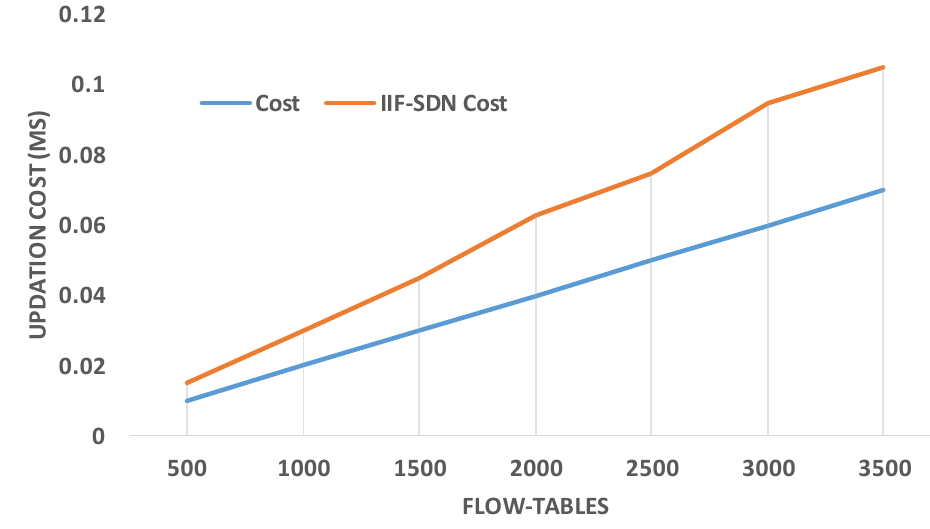
Figure 12. Flow-table update cost at the SDN controller.